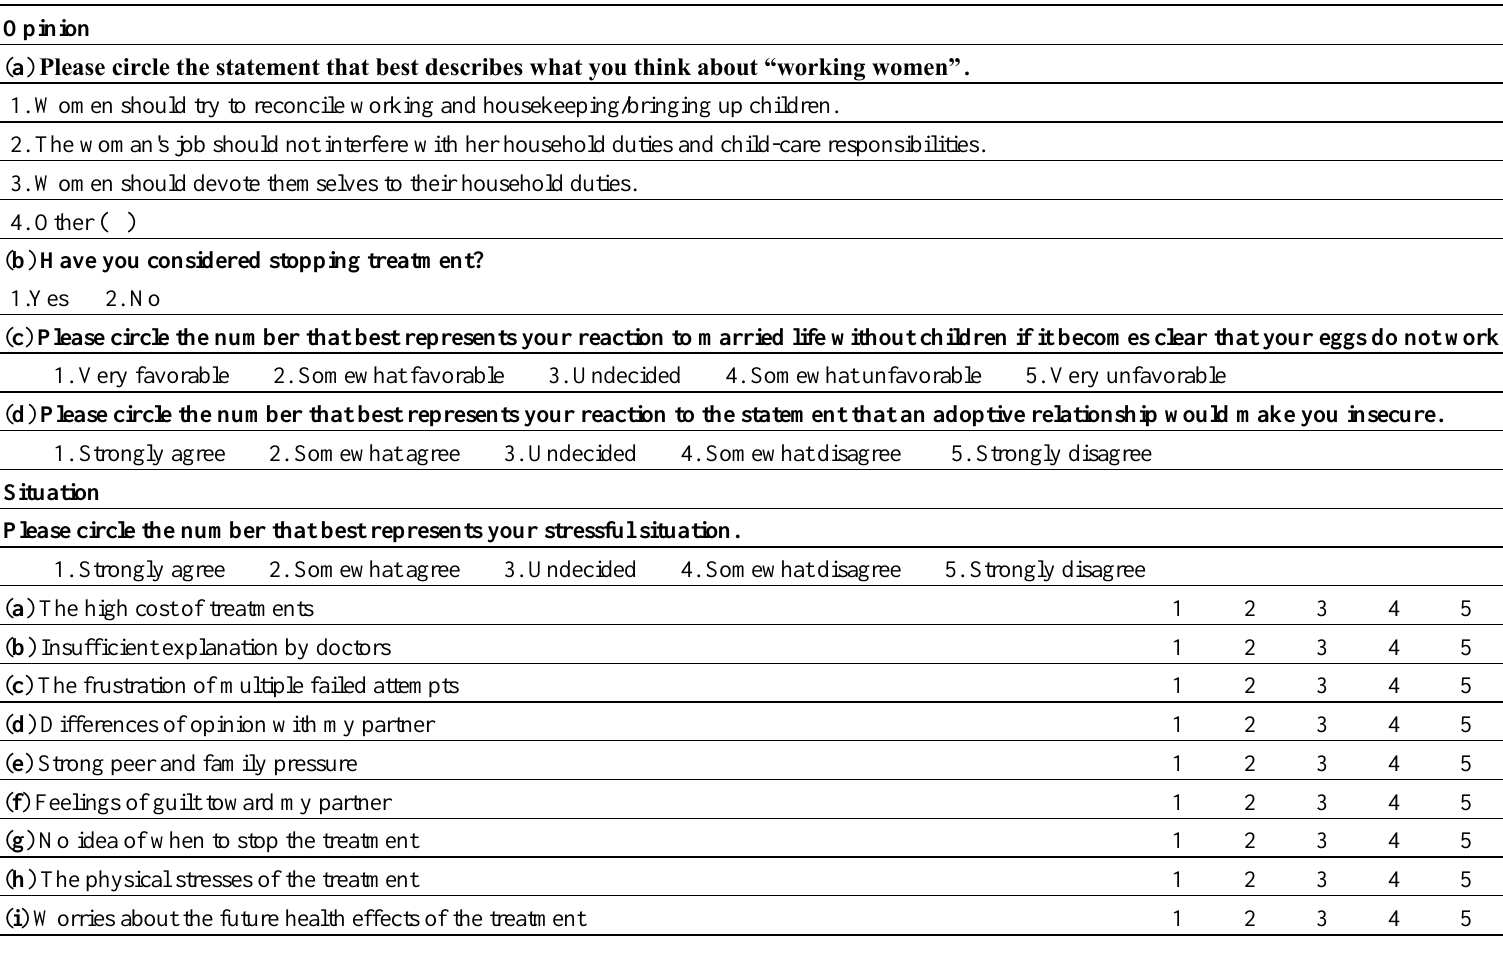
Table 1. Original